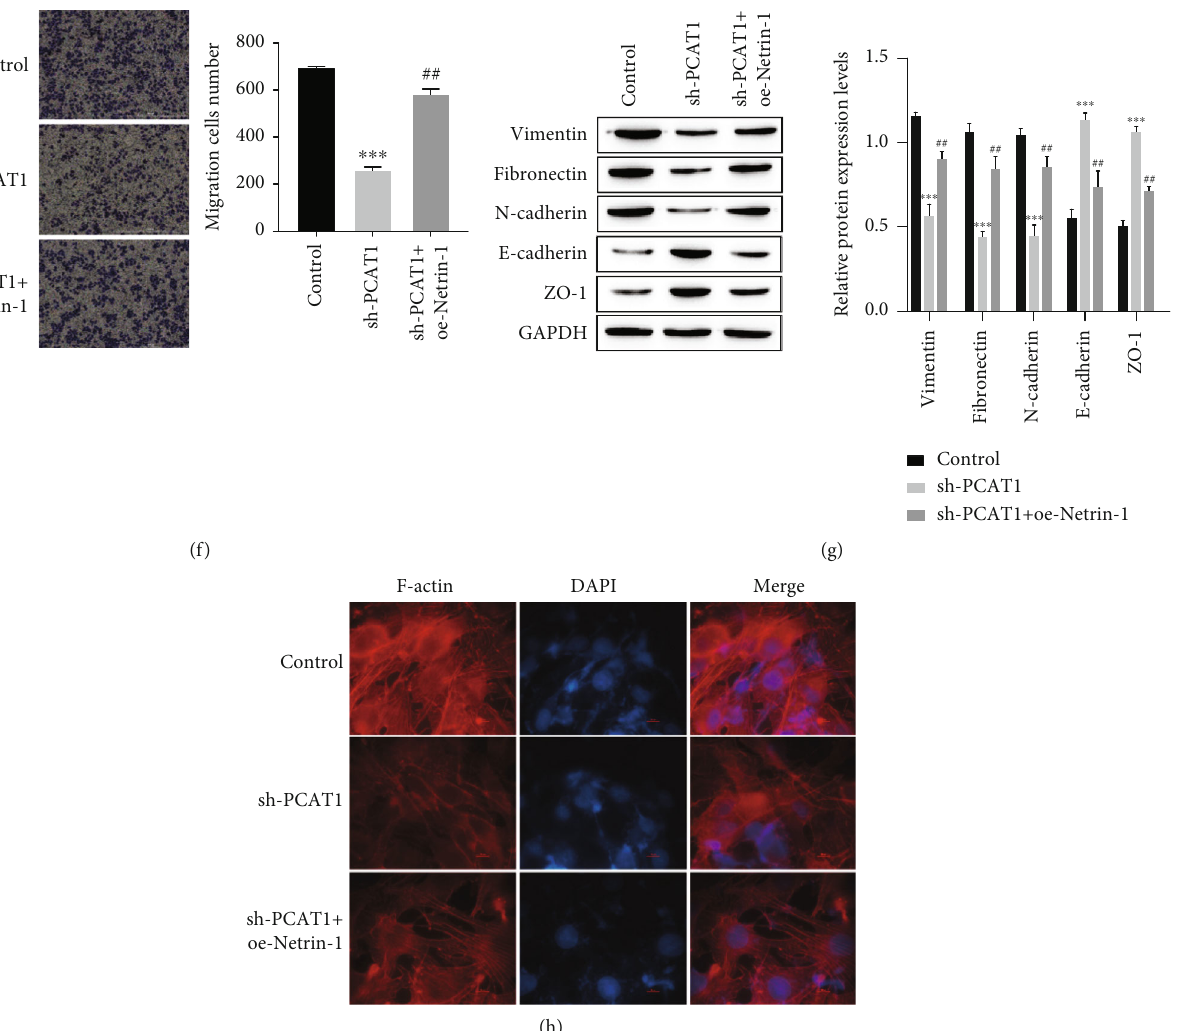
Figure 5: PCAT1 regulation of the miR-329-3p/Netrin-1 axis a ff ects the biological behavior of T84 and the ability of fi broid actin to form stress fi bers. (a) The proliferation activity of T84 cells was detected by CCK-8 assay. (b) Transwell assays were used to detect the migration ability of T84 cells. (c) Western blot was used to detect the expression of EMT-related proteins. (d) Stress fi bers formed by F-actin were detected in HUVECs by immuno fl uorescence. (e) The proliferation activity of T84 cells was detected by CCK-8 assay. (f) Transwell assays were used to detect the migration ability of T84 cells. (g) Western blot to detect the expression of EMT-related proteins. (h) Stress fi bers formed by F-actin were detected in HUVECs by immuno fl uorescence. ∗∗ P < 0 : 01 , ∗∗∗ P < 0 : 001 vs Control; # P < 0 : 05 , ## P < 0 : 01 vs